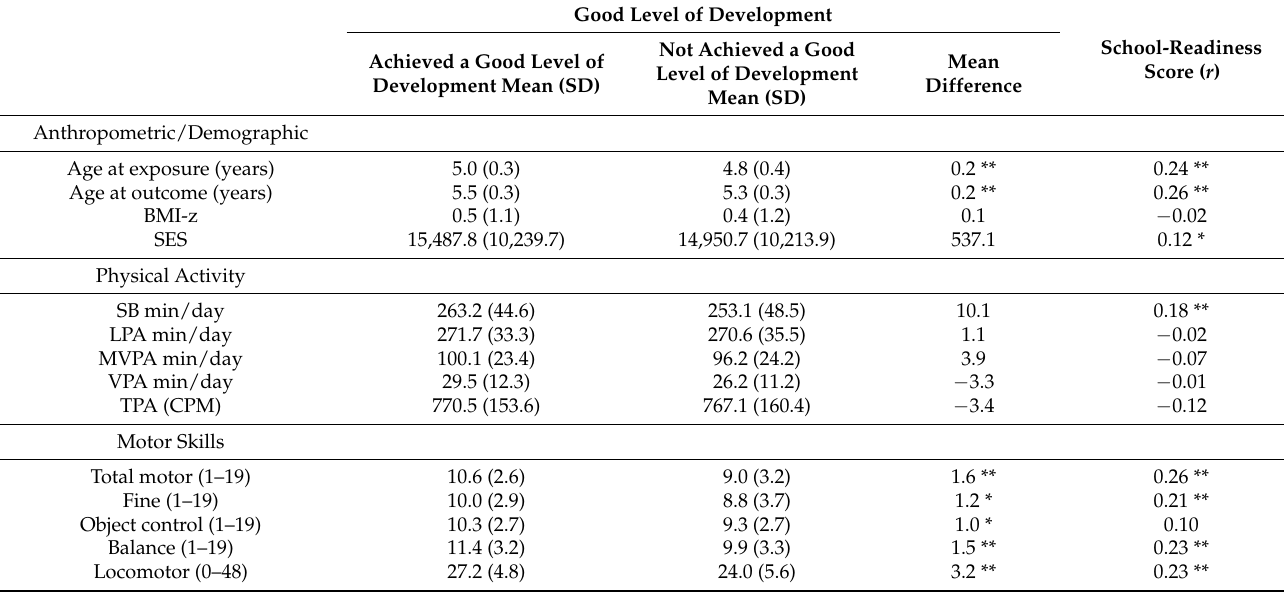
Table 4. Association between demographic, anthropometric and physical activity variables and a good level of development and school-readiness